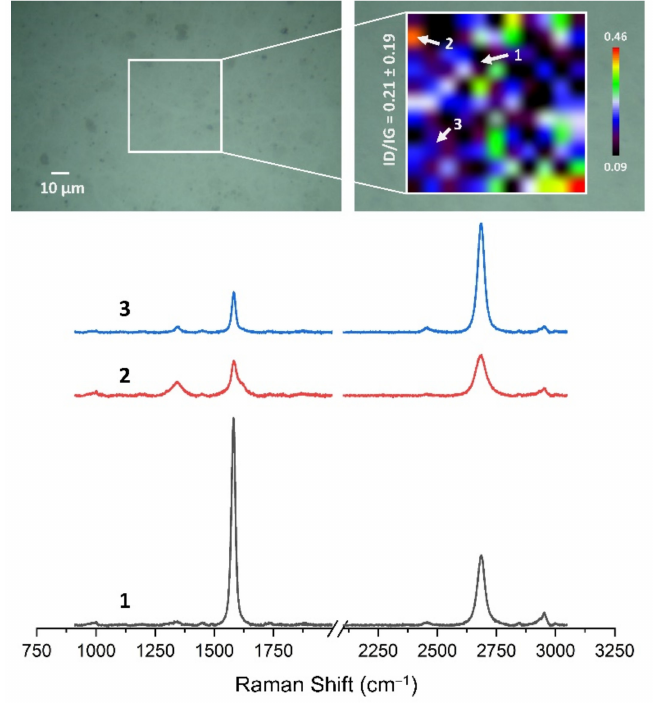
Figure 18. The Raman map and spectra of CVD graphene transferred onto Al 2 O 3 ceramic substrates etched with 5% HF